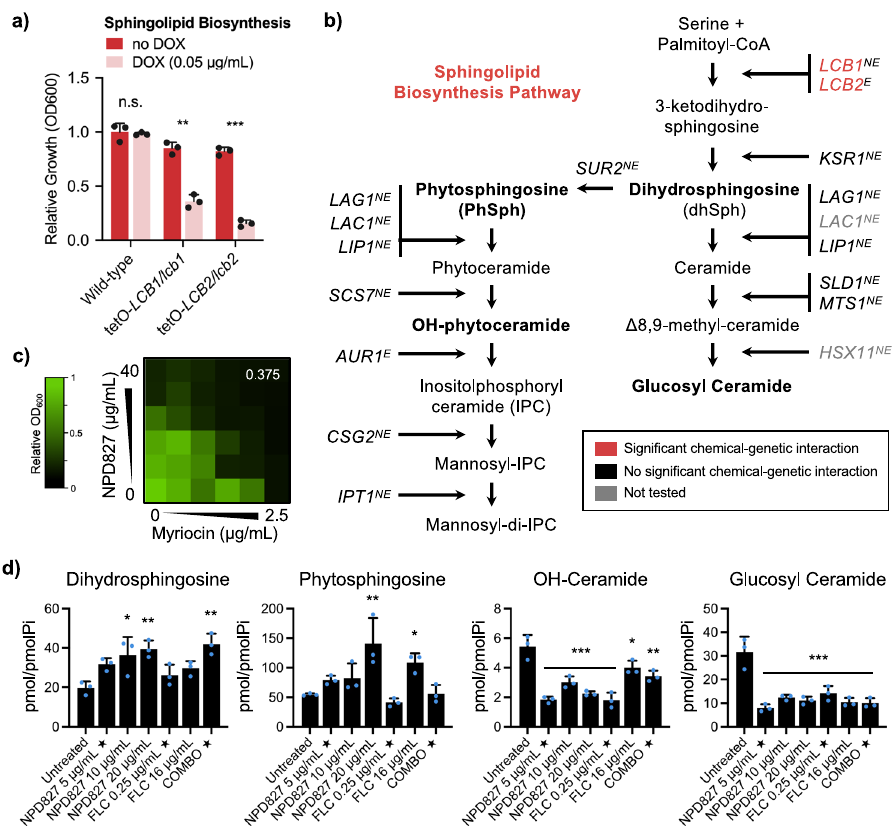
Fig. 3 NPD827 treatment results in accumulation of long chain sphingoid bases and the depletion of modi fi ed ceramides. a Conditional expression mutants of sphingolipid biosynthesis pathway components were pro fi led at a fi xed concentration of NPD827 (5 μ g/mL) in the absence and presence of doxycycline (DOX, 0.05 μ g/mL). Data are shown for those mutants with signi fi cant differences, presented as mean ±SD of technical triplicates. p -value: 0.00053 (tetO- LCB1/lcb1 Δ ), 0.00002 (tetO- LCB2/lcb2 Δ ). Signi fi cance was determined by performing multiple unpaired t tests comparing plus DOX conditions for each strain with no DOX. p -value: **<0.005, ***<0.0005. b Overview of sphingolipid biosynthesis pathway labeled with gene names of conditional expression mutants that were tested for sensitivity to NPD827. E denotes essential genes and NE denotes non-essential genes. Genes coloured in red were identi fi ed as signi fi cantly hypersensitive to NPD827 upon transcriptional repression with doxycycline (DOX, 0.05 μ g/mL). c Checkerboard assays were performed with NPD827 and the SPT inhibitor myriocin against a wild-type strain of C. albicans (SN95). Assays were performed and are presented as previously described in Fig. 1c. FICI values are displayed in the top right corner of each checkerboard. d Abundance of key sphingolipid species with signi fi cant differences in compound-treated samples (star indicates concentrations used in combination treatment). Data are expressed as mean±SD of n = 3, biologically independent replicates. p -value, compared to untreated: Dihydrosphingosine, 0.0086 (NPD827 10 µ g/mL); 0.0023 (NPD827 20 µ g/mL); 0.0008 (FLC 16 µ g/mL); Phytosphingosine, 0.0009 (NPD827 20 µ g/mL); 0.0313 (Combination [FLC 0.25 µ g/mL + NPD827 5 µ g/mL]); OH-Ceramide, <0.0001 (NPD827 5 µ g/mL, 20 µ g/mL, FLC 0.25 µ g/mL); 0.0001 (NPD827 10 µ g/mL); 0.0007 (FLC 16 µ g/mL); 0.0102 (Combination [FLC + NPD827]); Glucosyl Ceramide, <0.0001 (all samples). Signi fi cance determined by one-way ANOVA with Bonferroni ’ s multiple comparisons test, where all treatment conditions were compared to the wild-type untreated condition. p -value: *<0.05, **<0.005, ***<0.0005. Source data are provided as a Source Data fi